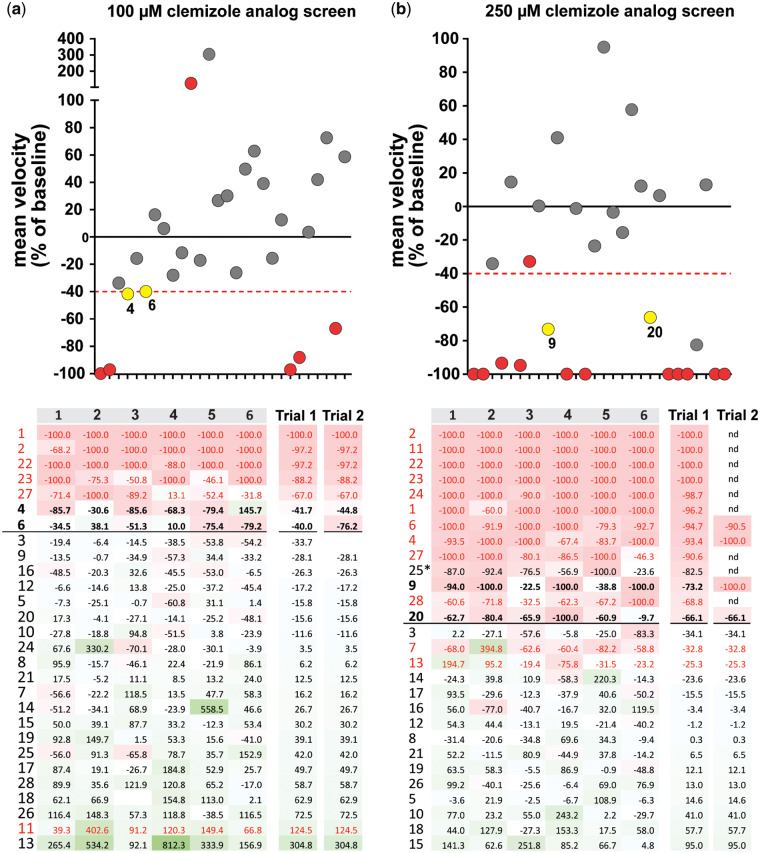

Phenotypic screening of clemizole analogues. Twenty-eight clemizole analogues were screened for efficacy in suppressing the high-velocity seizure-like swim behaviour observed in scn1lab mutant zebrafish. Plots show the change in mean swim velocity of 5 dpf larvae screened at (a) 100 µM, or (b) 250 µM. Threshold for inhibition of seizure activity (positive hits—yellow data points) was determined as a reduction in mean swim velocity of ≥40% (red dashed line). The red data points represent compounds that were classified as toxic after 90-min exposure. The heat map shows the % change in velocity for the six individual larva from the first trial (1–6). Mean velocity change from six individual fish is shown for trial 1 and 2. Clemizole analogue 25 (*) failed to go into solution at 250 µM so it was not considered for further testing.